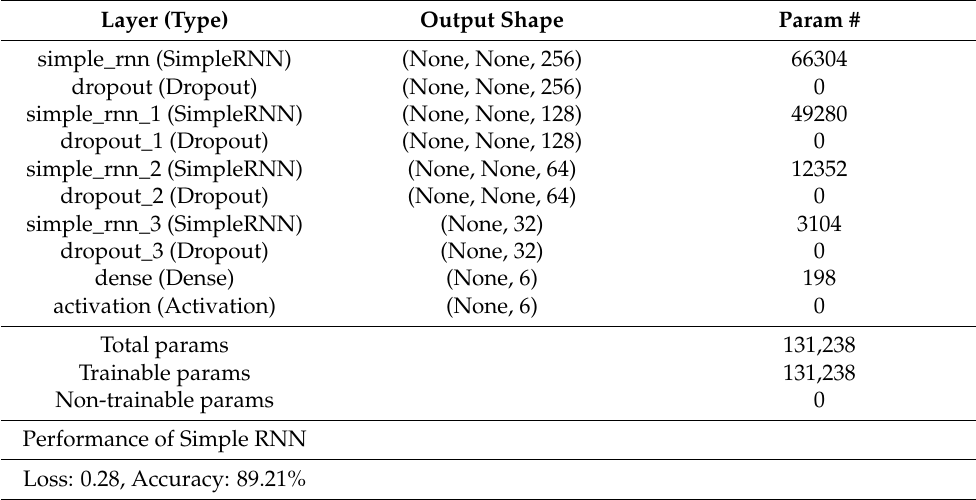
Table 5. Summary of model parameters based on fine-tuned RNN neural network.